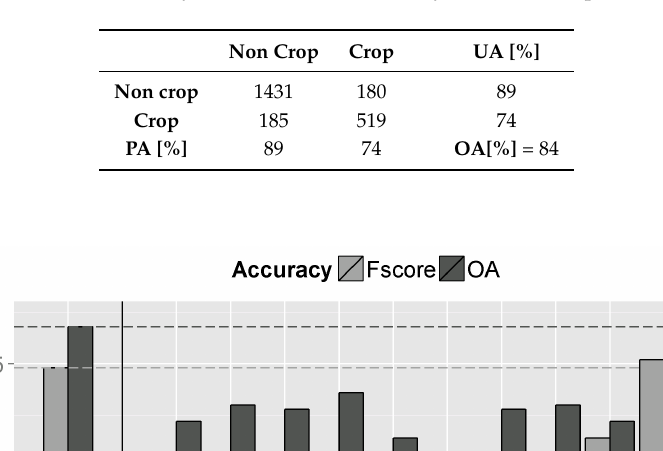
Table 2. Confusion matrix for the regional cropland map using the 2315 validation points. Overall